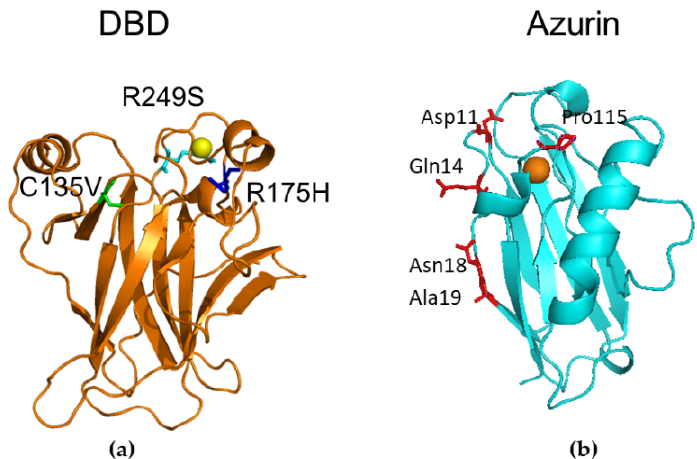
Figure 1. ( a ) Graphical representation of the DBD portion of p53 wt from chain B of 1TUP PDB entry [50]. Amino acids undergoing single mutations are marked: p53 R249S (azur sticks) p53 C135V (green sticks) and p53 R175H (blue sticks). Zn ion is represented as a yellow sphere. ( b ) Graphical representation of the blue copper protein Azurin (Az) from chain B of the 1AZU PDB entry [54]. The main amino acids expected to be involved in the interaction with DBD are marked in red. Cu ion is represented as an orange sphere. The figures were created by Pymol [55].